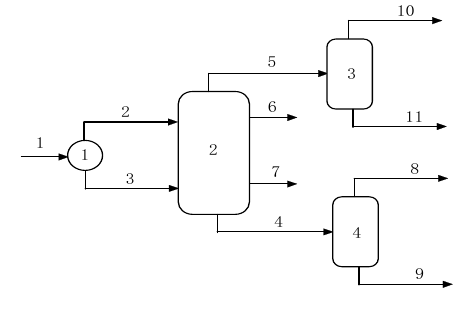
Fig. 3. Extraction progress of composing juice The process has 4 equipments, 7 components and 88 variables which are 11 matter flow variables and 77 component variables = Parameters of the proposed algorithm are as follows, the number of subintervals is 3, and maximum iteration number is 1000 G = . The reconciliation results max compared with Crowe 1 and NLP 26 are shown in Tab.5 (a part of variables are listed, * represents unmeasured variable) and